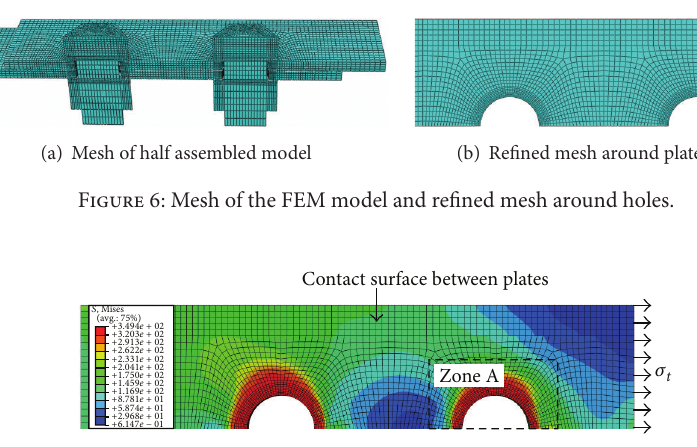
Figure 7: Mises stress distribution on the contact surface between plates ( 𝜎 𝑡 = 175